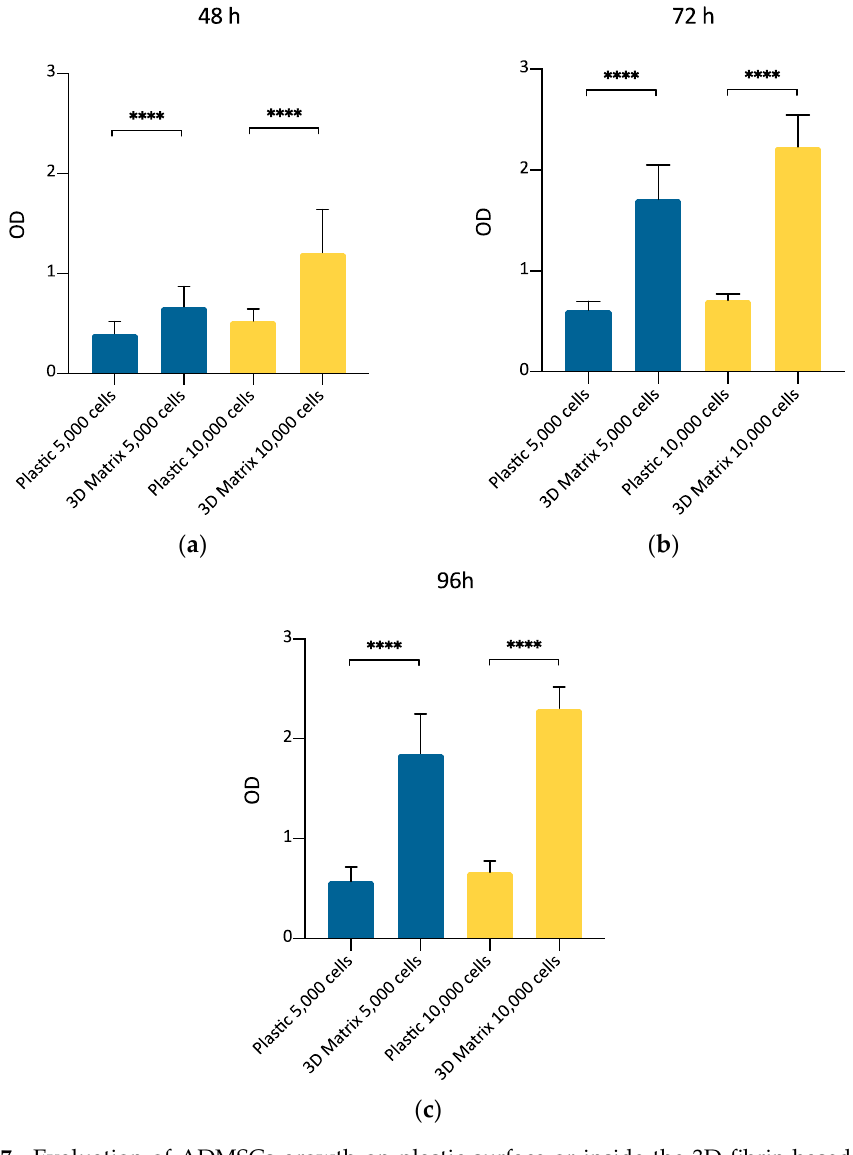
Figure 7. Evaluation of ADMSCs growth on plastic surface or inside the 3D fibrin-based matrix prepared from PPP, by MTT assay at 48 ( a ), 72 ( b ), and 96 ( c ) hours. The number of cells seeded was 5000 / well (blue bars) or 10,000 / well (yellow bars). The metabolic MTT assay confirmed the results observed by direct cell count. 3D fibrin-based matrix is a suitable environment to stimulate ADMSCs’ growth. Statistically significant differences are indicated as follows: **** p ≤ 0.0001.